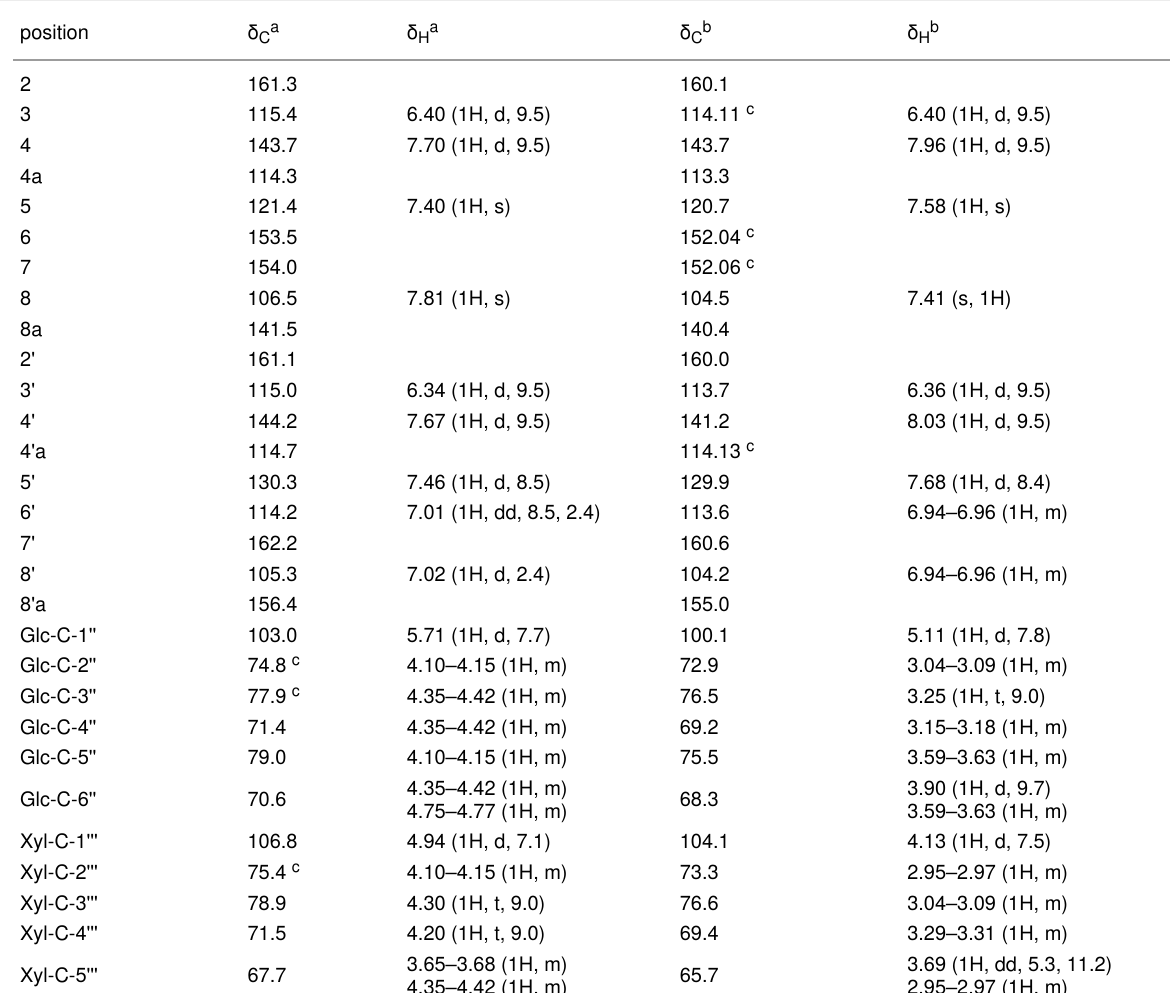
Table 1: 1 H and 13 C NMR Spectroscopic Data for 1 ( δ in ppm, J in Hz). position